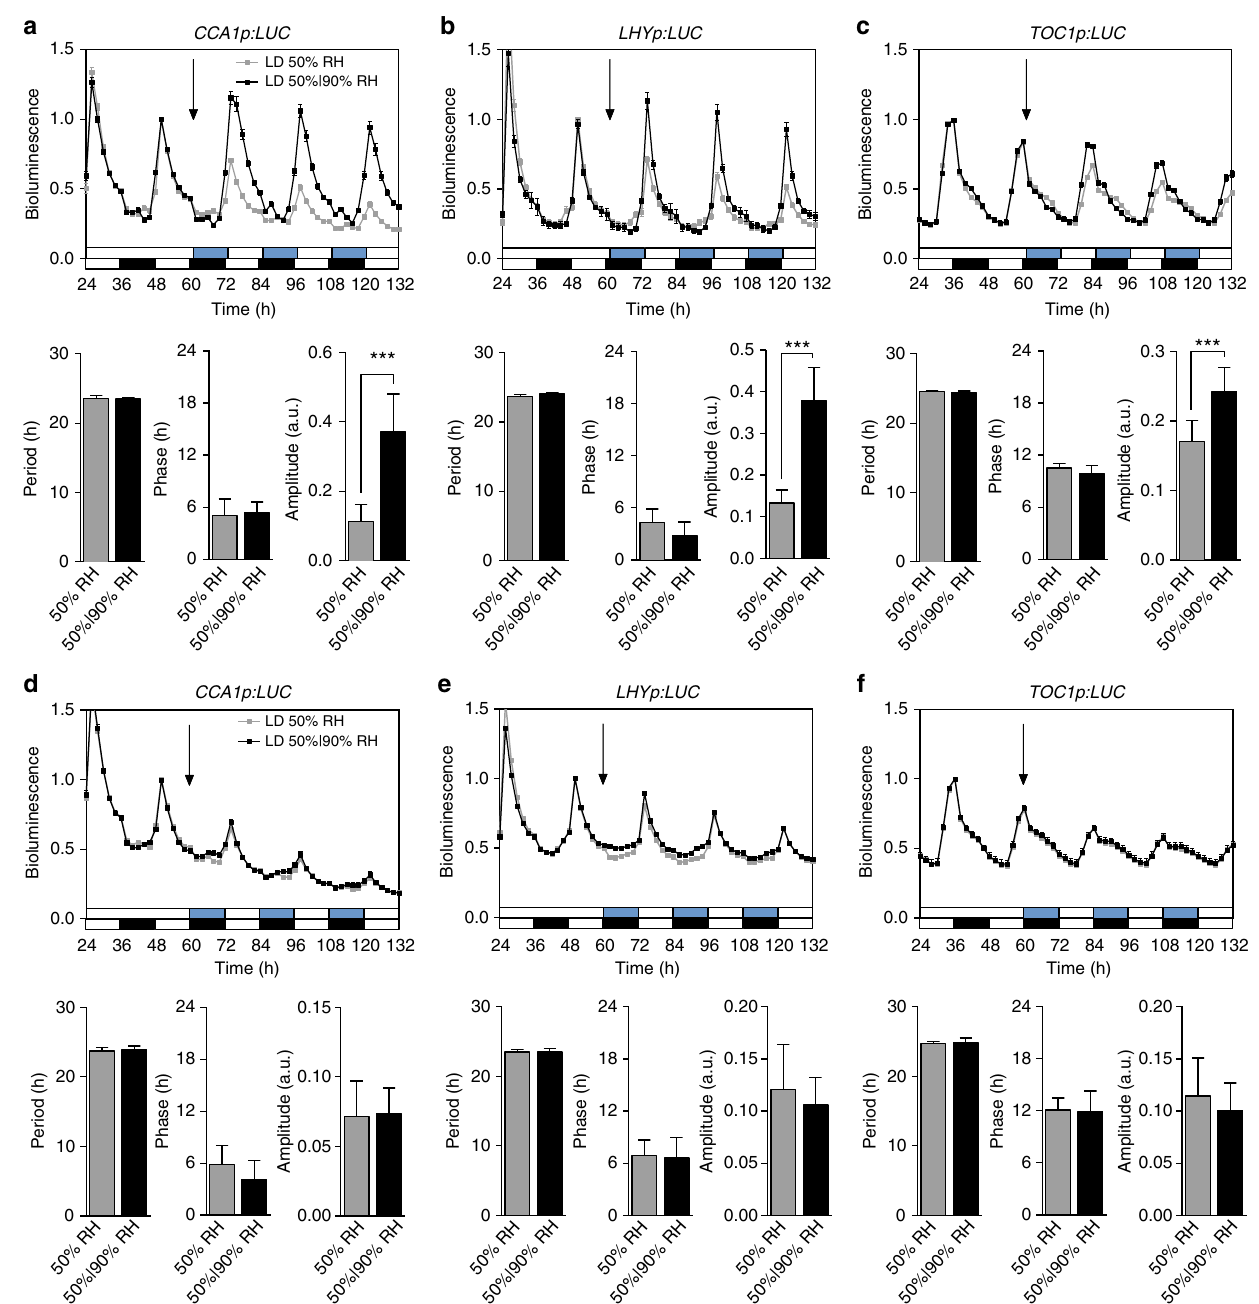
Fig. 3 Simulated natural conditions increase the amplitude of the circadian clock under the light-dark cycle. a – c CCA1p:LUC ( a ), LHYp:LUC ( b ) and TOC1p: LUC ( c ) activity rhythms (top) and calculated periods, circadian phases and amplitudes (bottom) in WT grown under LD with constant 50% RH (grey) or simulated natural conditions (black). Simulated natural conditions represent 12 h 50% RH/12 h 90% RH cycles with the 2-h overlap of high humidity and light in the morning as observed in nature. Luciferase activity was normalized to the peak value between 40 and 60 h. Periods, circadian phases and amplitudes were calculated by FFT-NLLS analysis of the data between 60 and 132 h. White and black bars represent light and dark, respectively; white and blue bars represent 50% RH and 90% RH, respectively; black arrow, start of humidity entrainment conditions. Data are shown as mean ± s.e.m. and mean ± s.d. for activity rhythms and their calculated parameters, respectively; n = 24 plants; t -test, *** p < 0.001. Relative amplitude error values of ≤ 0.7 were considered rhythmic. This experiment was repeated three times with similar results. d – f CCA1p:LUC ( d ), LHYp:LUC ( e ) and TOC1p:LUC ( f ) activity rhythms (top) and calculated periods, circadian phases and amplitudes (bottom) in WT grown under LD with constant 50% RH (grey) or 12 h 50%/12 h 90% RH (blue) with no overlap of light and high humidity in the morning. Data are shown as mean ± s.e.m. and mean ± s.d. for activity rhythms and their calculated parameters, respectively; n = 24 plants. Relative amplitude error values of ≤ 0.7 were considered rhythmic. This experiment was repeated three times with similar